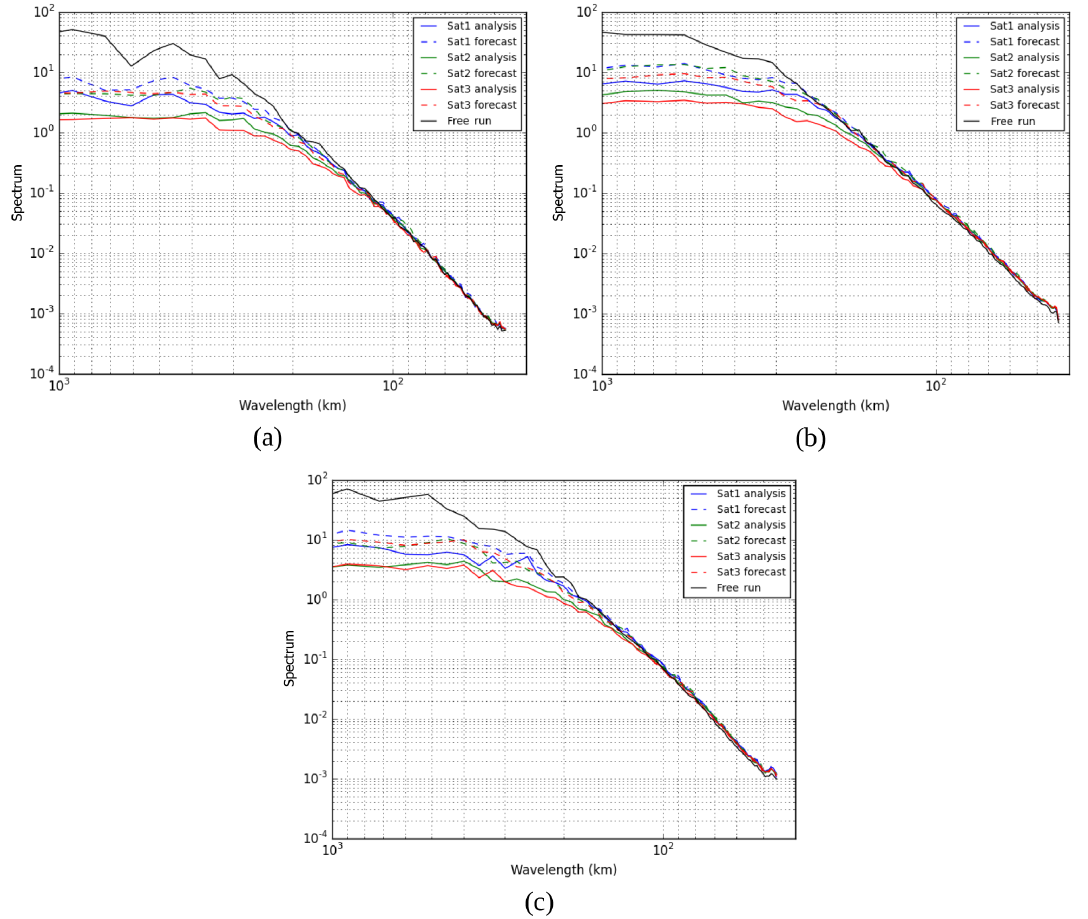
Figure 10. Sea level error energy spectrum in the GS (a) , AC (b) and KU (c) for FR (black), Sat1 (blue), Sat2 (green) and Sat3 (red). Analyses are shown with solid lines and 7-day forecasts with dashed